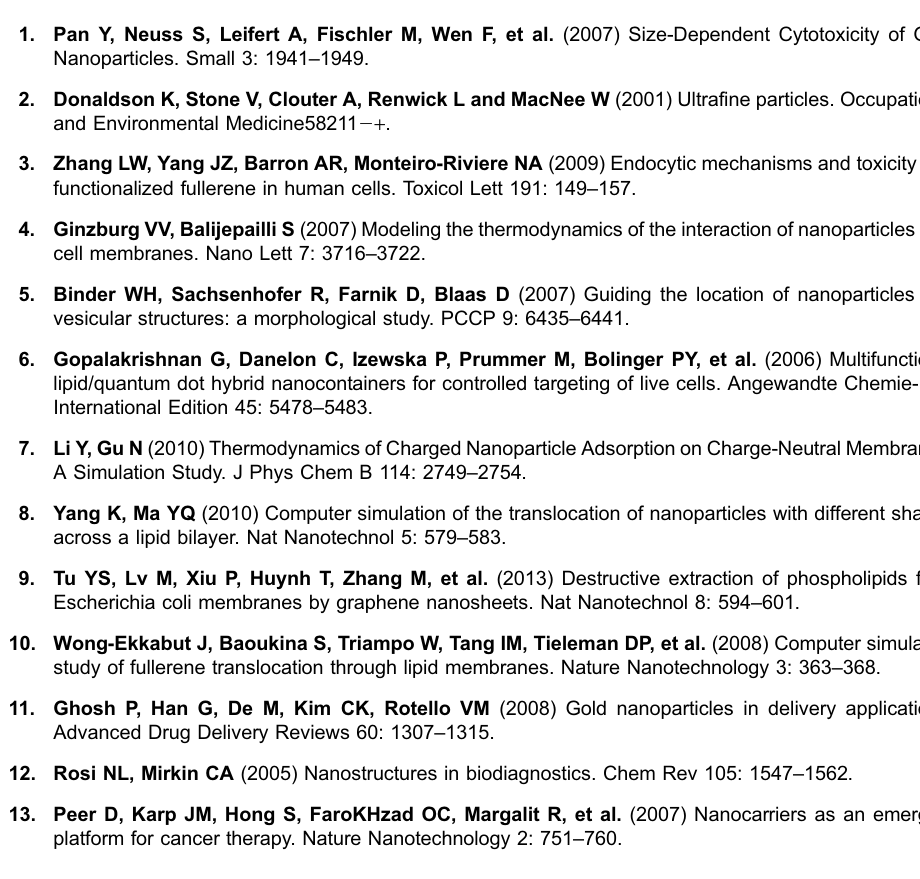
Table S1. Number of lipids in SR, buffer and LR region. doi:10.1371/journal.pone.0114152.s012 (DOCX) Text S1. Forcefield: AOPC and AuNP.